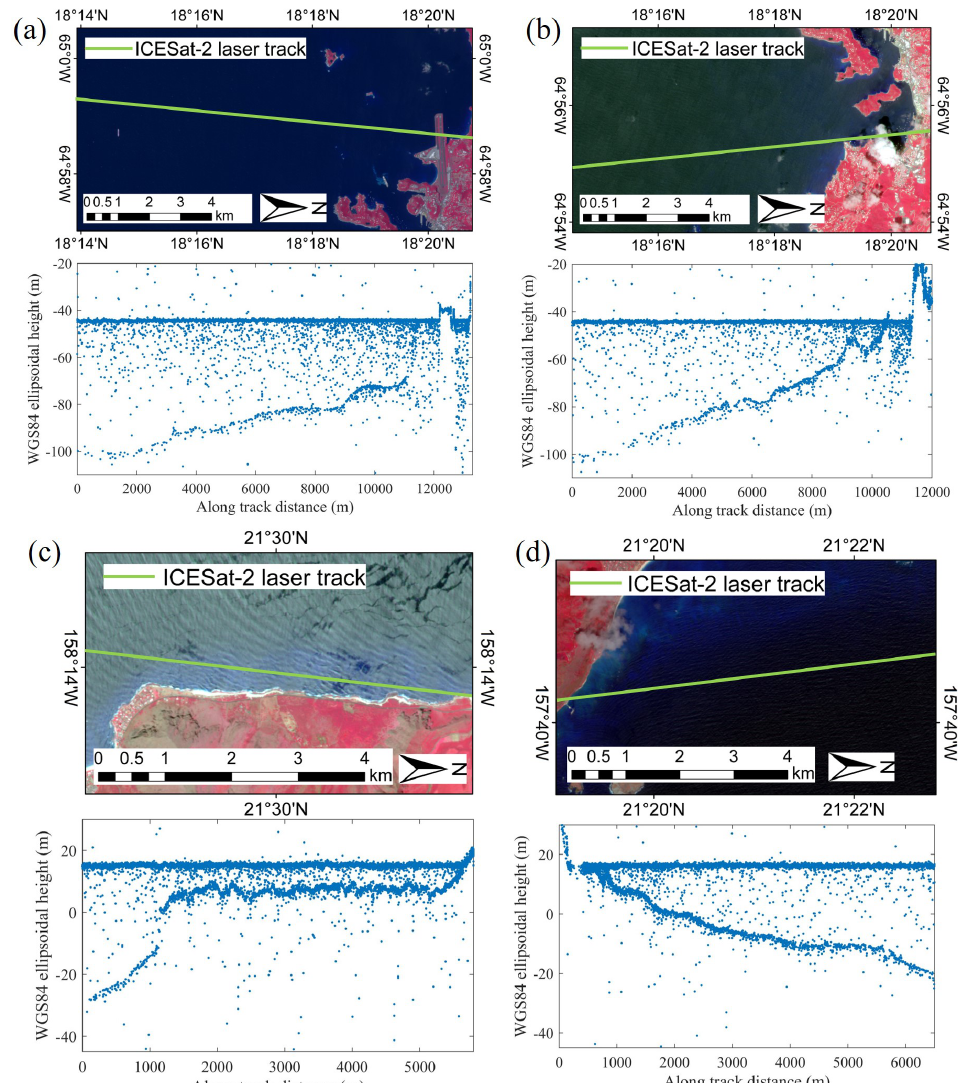
Figure 5. Four ICESat-2 ground tracks in enlarged Sentinel-2 images and their corresponding along- track geolocated photons from ICESat-2 ATL03 products in two study areas. ( a , b ) correspond to St. Thomas, whereas ( c , d ) correspond to Hawaii. In all image subfigures, green lines represent the ICE- Sat-2 ground tracks. In all subfigures containing ATL03 raw geolocated photons, the x -axis denotes the relative along-track distance of the ICESat-2 ground track, and the y -axis is the WGS84 ellipsoi- dal height in meters. Table 2. Information of ICESat-2 tracks and intrinsic optical parameters of local water from MODIS data.